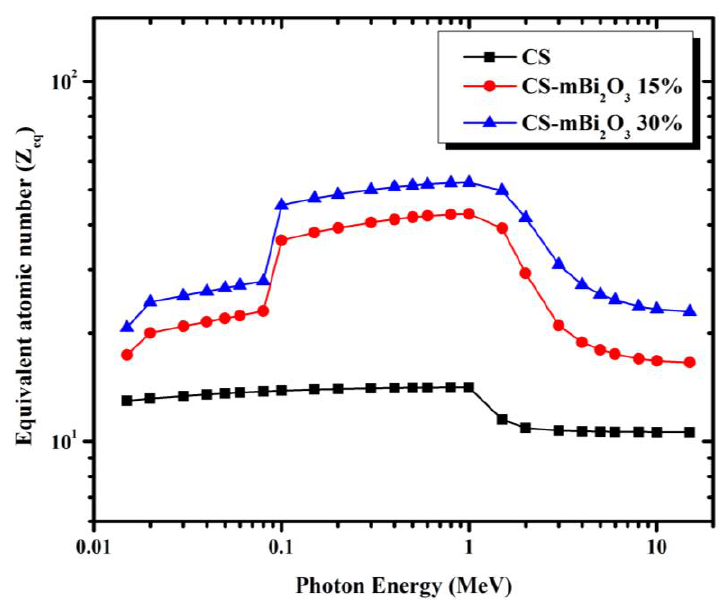
the lowest value.